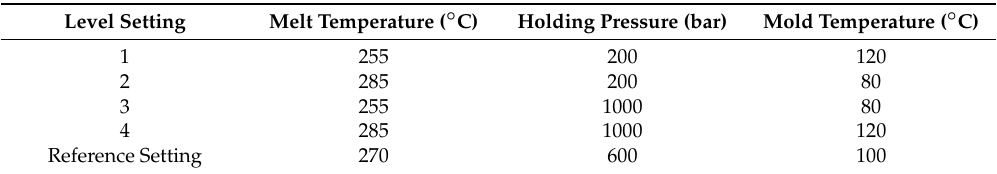
Table 9. Applied fractional factorial experimental design.